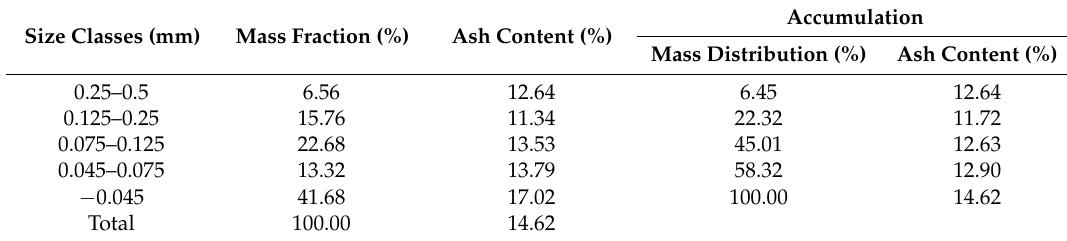
Table 2. Particle size distribution of the coal sample.